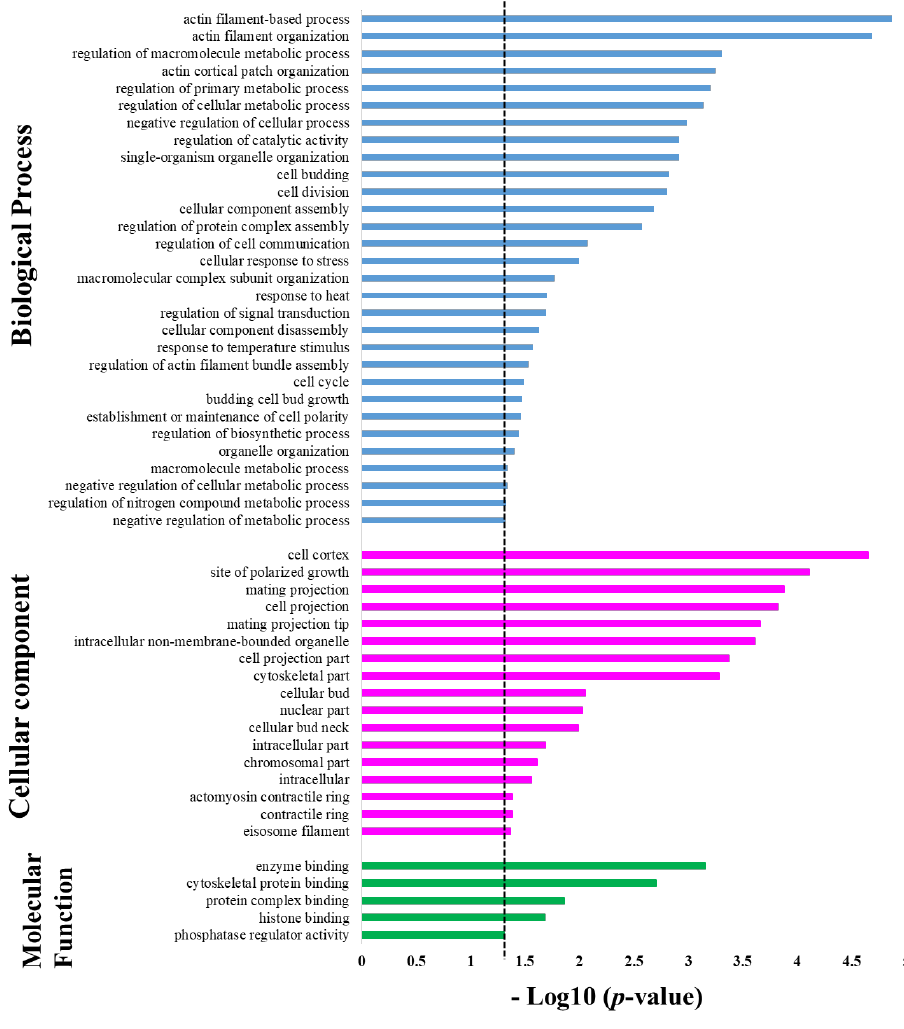
Figure 3. Gene ontology enrichment in biological process, cellular component, and molecular function. The signification enrichment in different categories of gene ontology of protein targets of Sub5 obtained by Saccharomyces cerevisiae proteome microarrays; ( p -value cutoff of 0.05 was indicated by dotted line). Biological process (blue), cellular component (pink), and molecular function